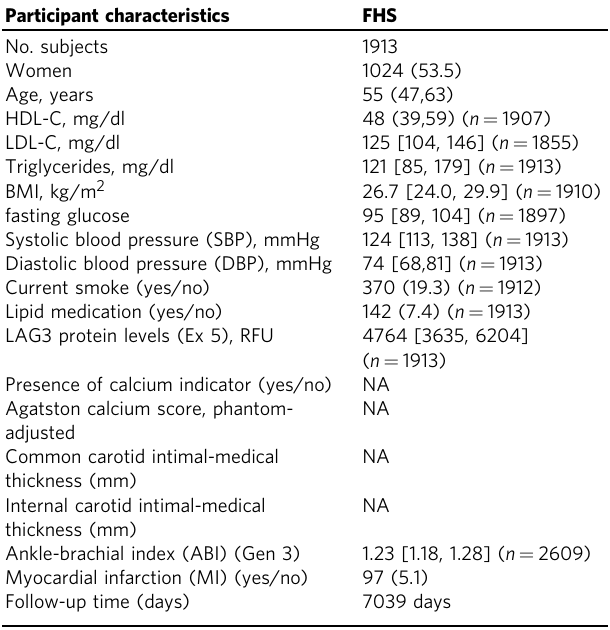
Table 2 Demographic characterization of FHS